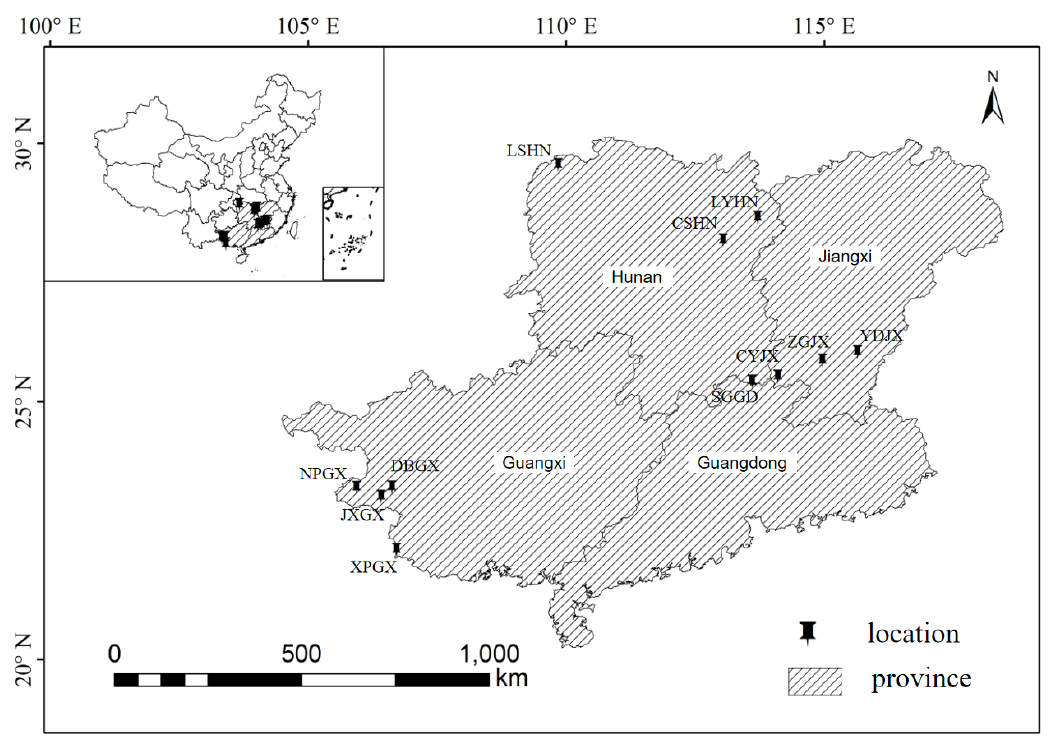
Figure 1. Map of S. wilsoniana locations showing different regional populations.